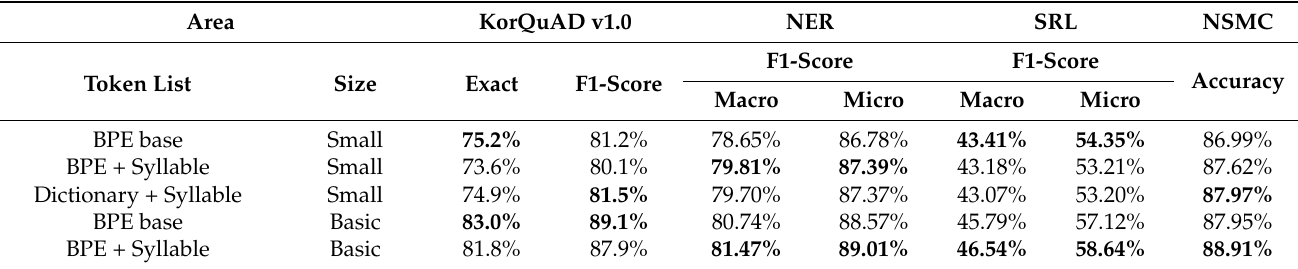
Table 3. Model test for KorQuAD v1.0, Named Entity Recognition, Semantic Role Labeling, and the Naver Sentiment Movie Corpus; scores in bold are the best overall.